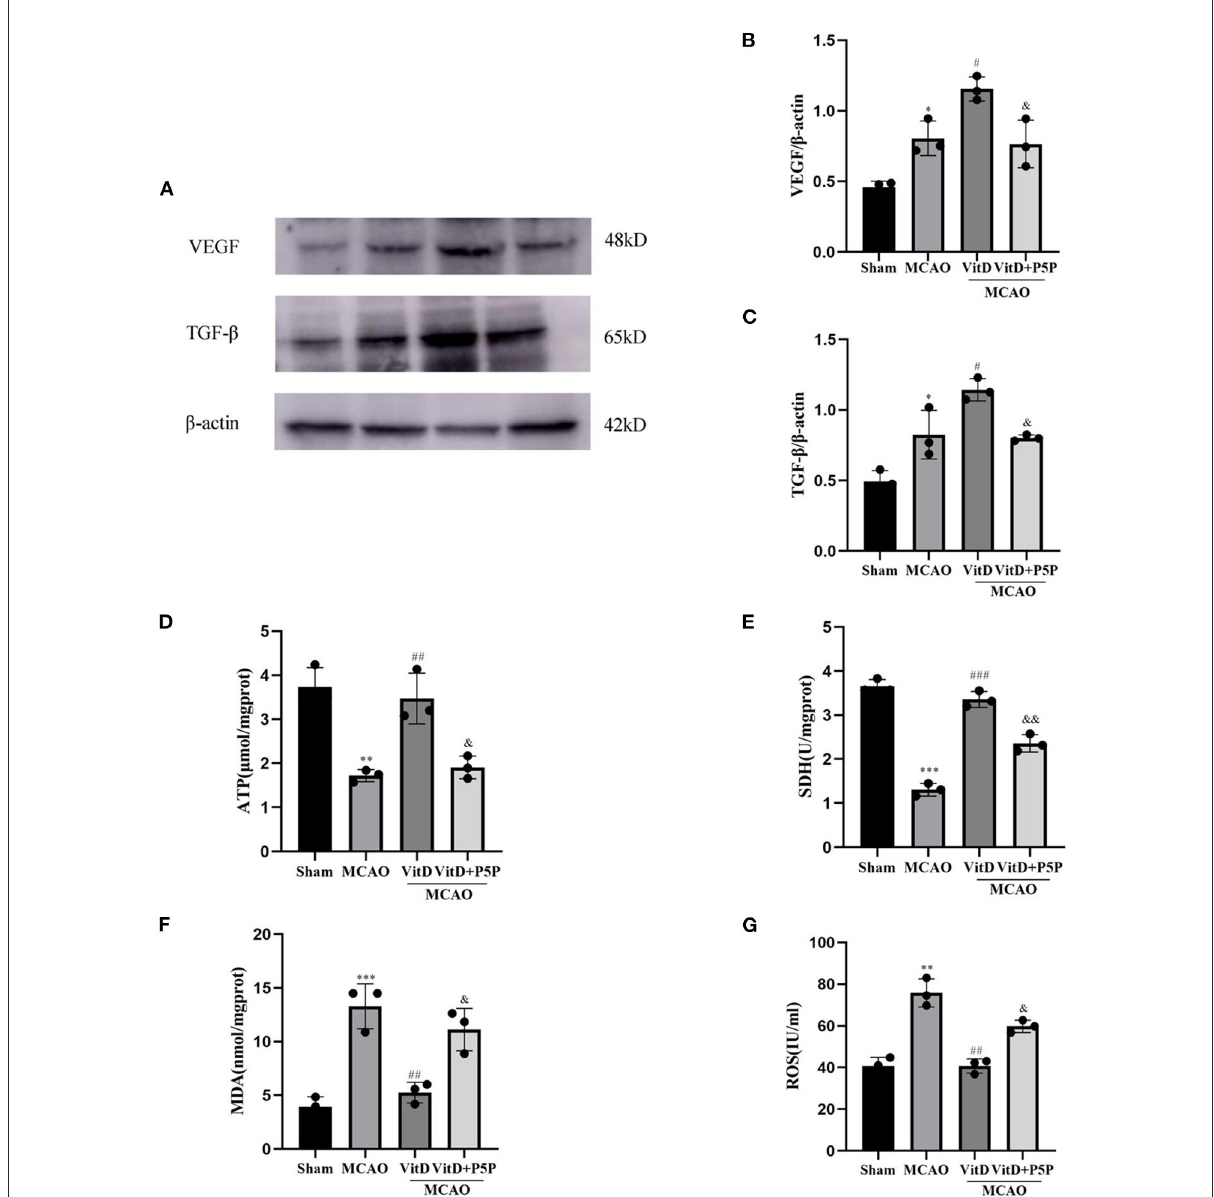
FIGURE6 1,25-D3 regulated the activities of mitochondrial ATPase and SDH, reduced the levels of ROS and MDA, and promoted the expression of TGF- β and VEGF. (A) Western blot images for TGF- β and VEGF. (B,C) The gray value of the band was analyzed using ImageJ. (D–G) ATPase and SDH, MDA, and ROS expression levels in mitochondria. All values are shown as the mean ± SEM. * P < 0.05, ** P < 0.01, *** P < 0.001 (vs. Sham), # P < 0.05, ## P < 0.01, ### P < 0.001 (vs. MCAO), & P < 0.05, && P < 0.01 (vs. VitD), n = 5. P5P, antagonist of VDR; Vit D,